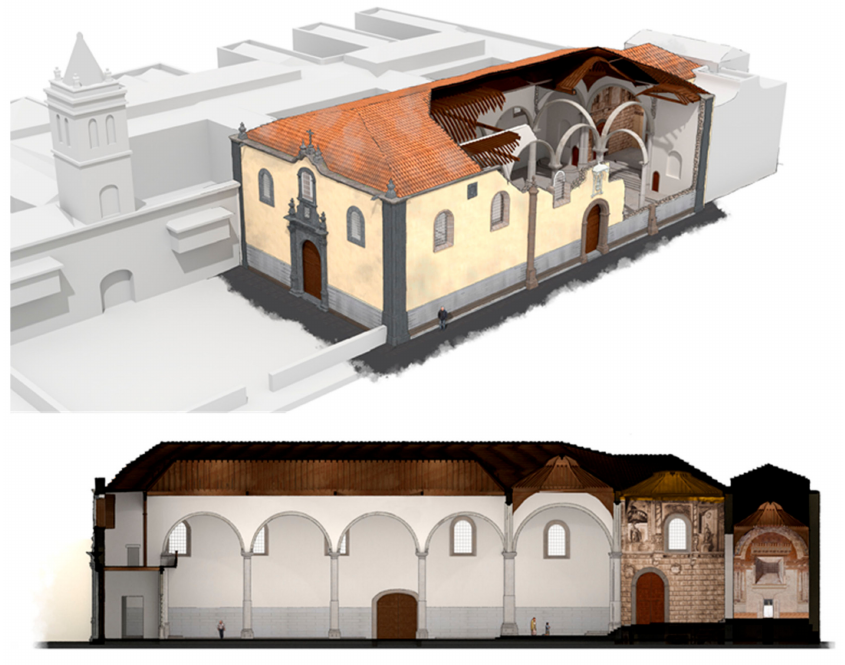
Figure 15. Virtual reconstruction of the St Augustine church located in the United Nations Educational, Scientific and Cultural Organisation (UNESCO) World Heritage City San Crist ó bal de La Laguna: axonometric representation and architectural section. Source: Cor-Ignis